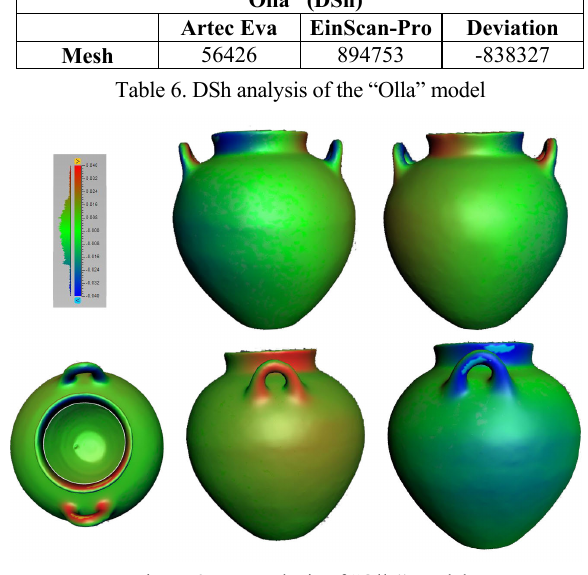
Figure 8. DF analysis of “Olla” model